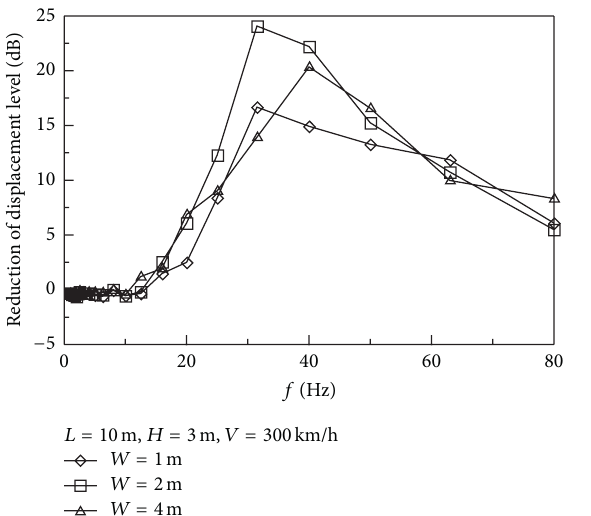
Figure 16: Influence of train speed on RDL.